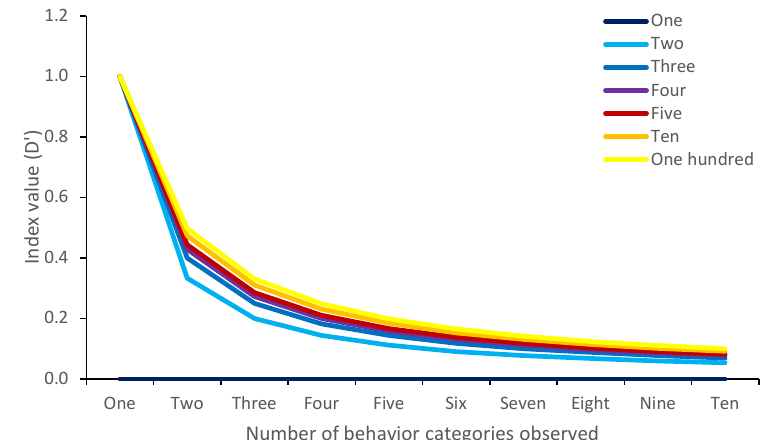
Figure 4. The effect of the number of observations on the Simpson’s index values. In this example, between one and ten behavior categories are observed per observation. All behavior categories are observed equally (e.g., when four behavior categories occur, they are all observed equally often). The figure demonstrates the effect of increasing numbers of observations of each behavior on the index values generated. Here, each behavior occurs at a different frequency (either once, twice, thrice, four, five, ten or one hundred times, during separate simulations). The figure shows that Simpson’s index values are not generated when only one behavior category occurs, and generally, higher index values are generated when behaviors are observed many times.